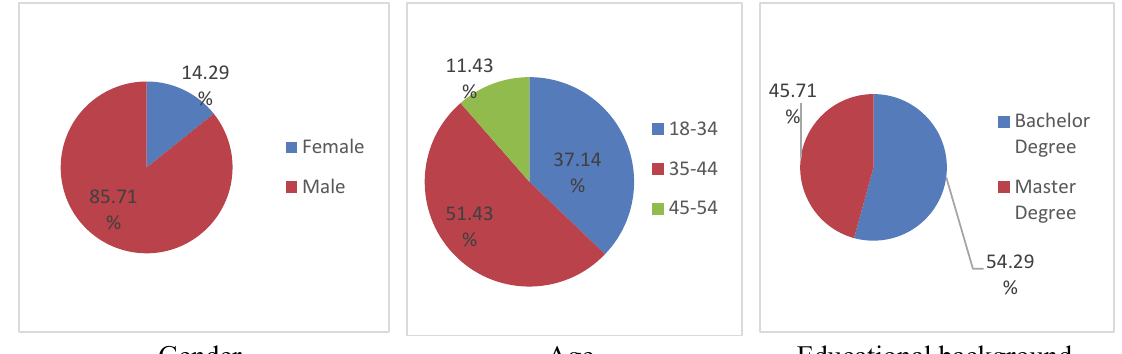
Fig. 1. Personal characteristics of the participants (Gender, Age and Educational